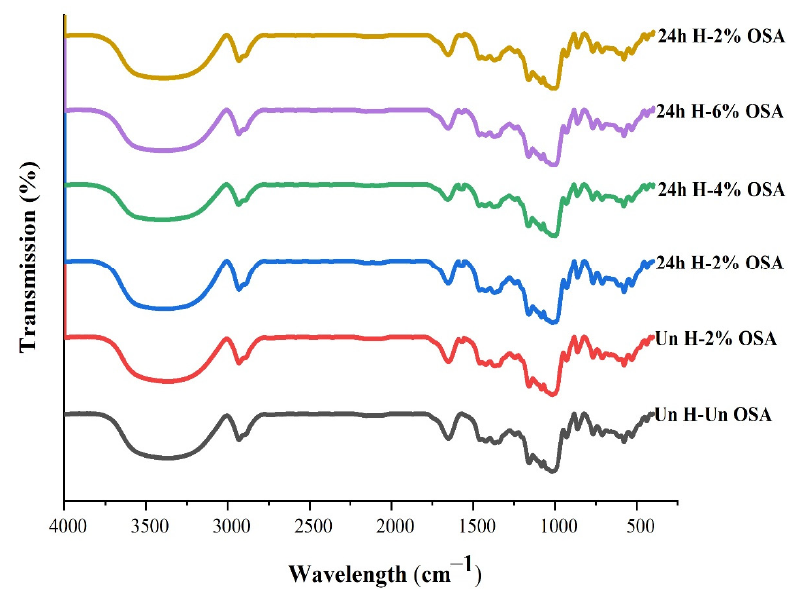
Figure 3. The FTIR diffraction pattern of OSA-modified high-amylose and native PMS (Kudzu) starch samples.